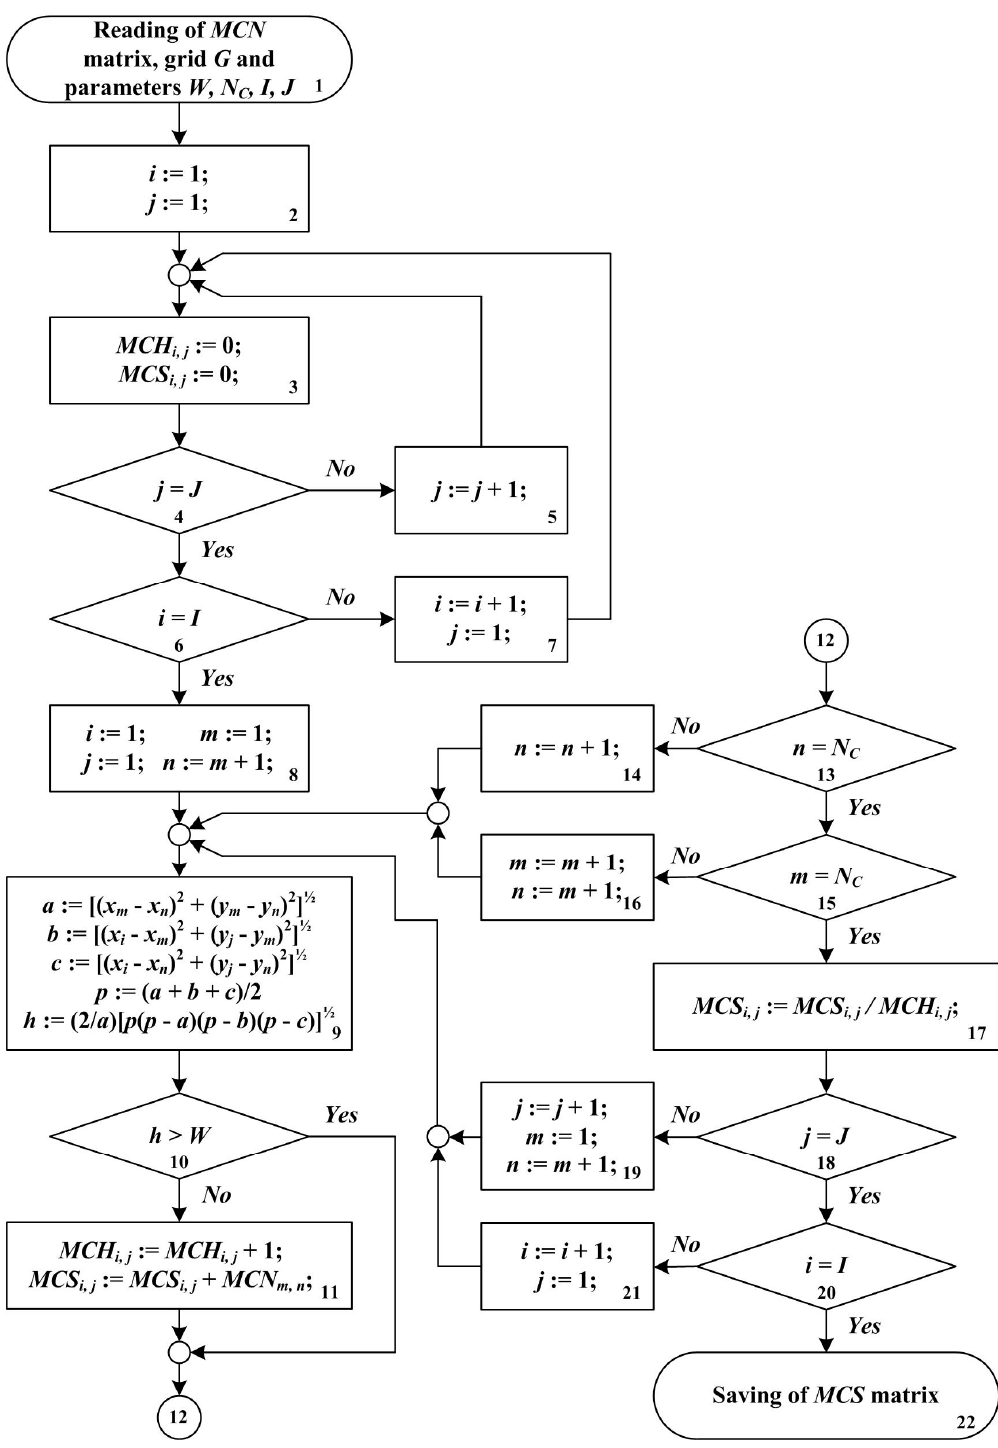
Figure 1. Block diagram of algorithm for image reconstruction of cracks.